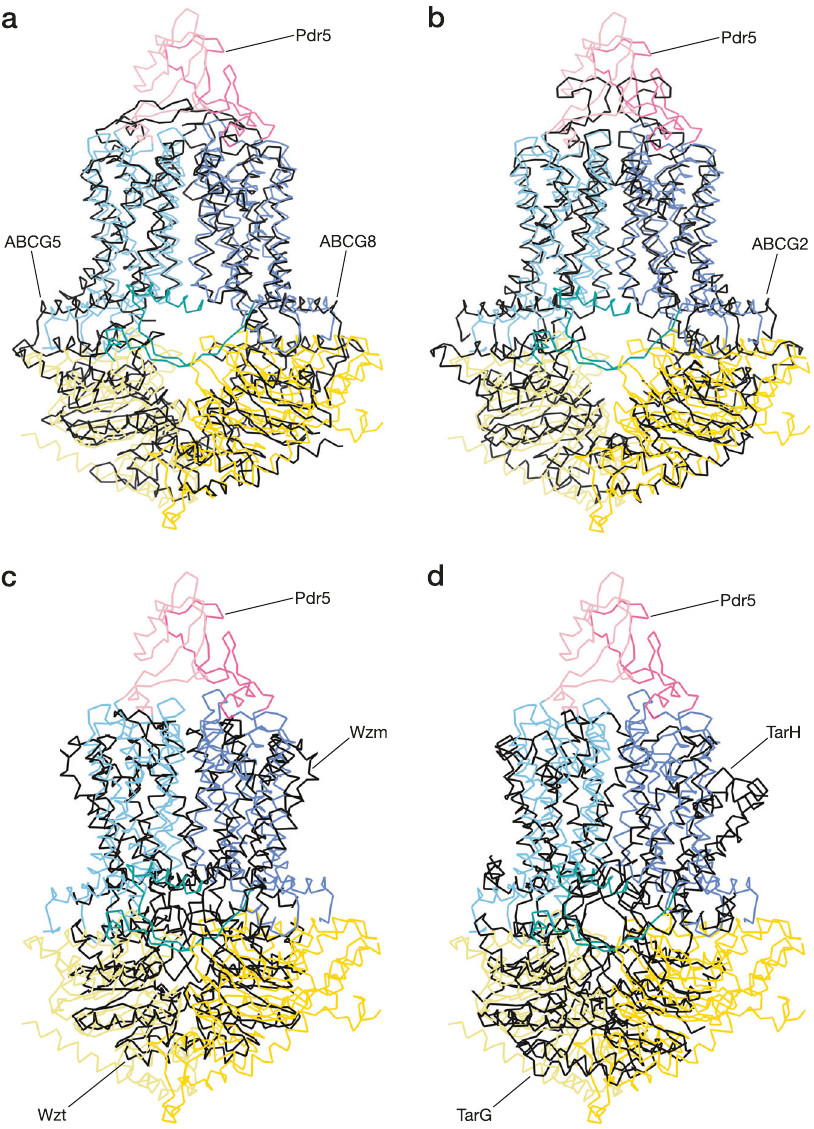
Fig. 2 Structural comparison of Pdr5 and related transporters. The panels show the superposition of Pdr5 and four related ABC transporters: a human sterol transporter ABCG5/8 (PDB-ID: 5DO7), b human multi-drug transporter ABCG2 (PDB-ID: 6XVI), c bacterial O-antigen polysaccharide transporter Wzm-Wzt (PDB-ID: 7K2T), d bacterial teichoic acid transporter TarGH (PDB-ID: 6JBH). The r.m.s.d. (root-mean-square deviations) of atomic positions in the amino-acid backbone are, for ABCG5/8: 4.3 Å, ABCG2: 3.9 Å, Wzm-Wzt: 9.2 Å, TarGHL: 14 Å. See also: Supplementary Table